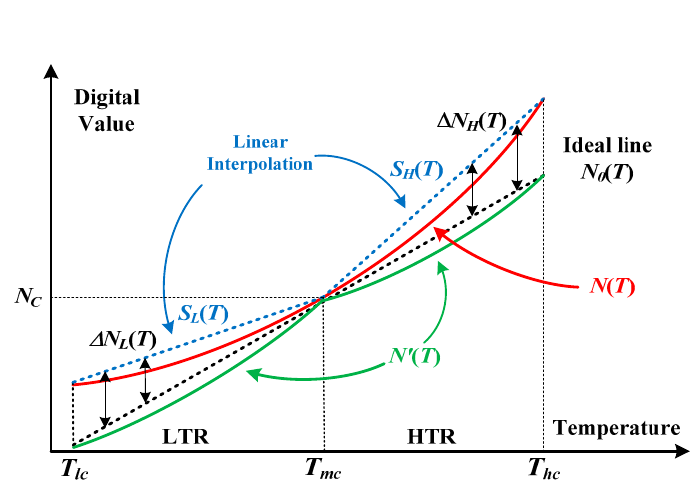
Figure 6. Concept of the linearity enhancement technique.